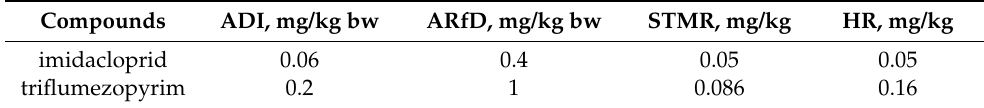
Table 3. Risk assessment data according to the JMPR report.